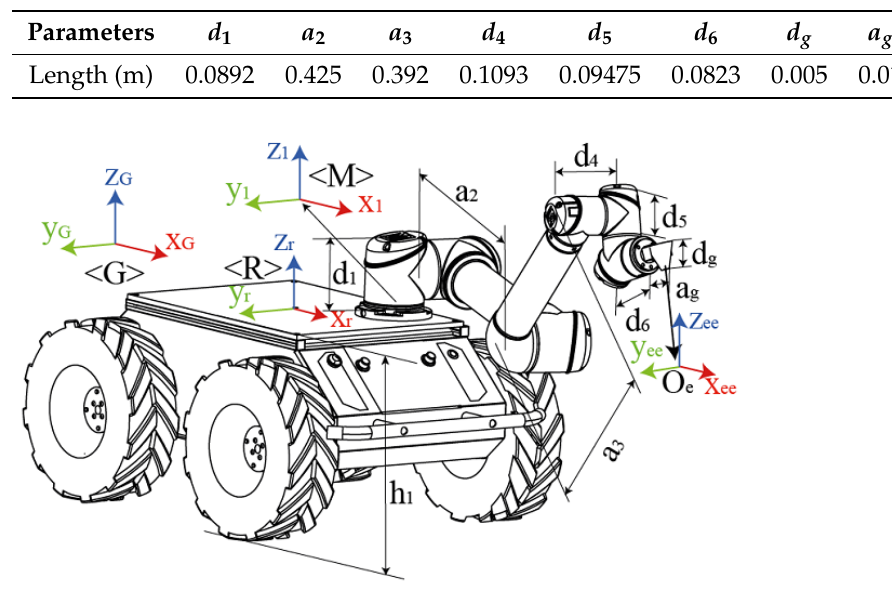
Figure 3. Mobile manipulator model: robotic arm with 6DOFs mounted on mobile